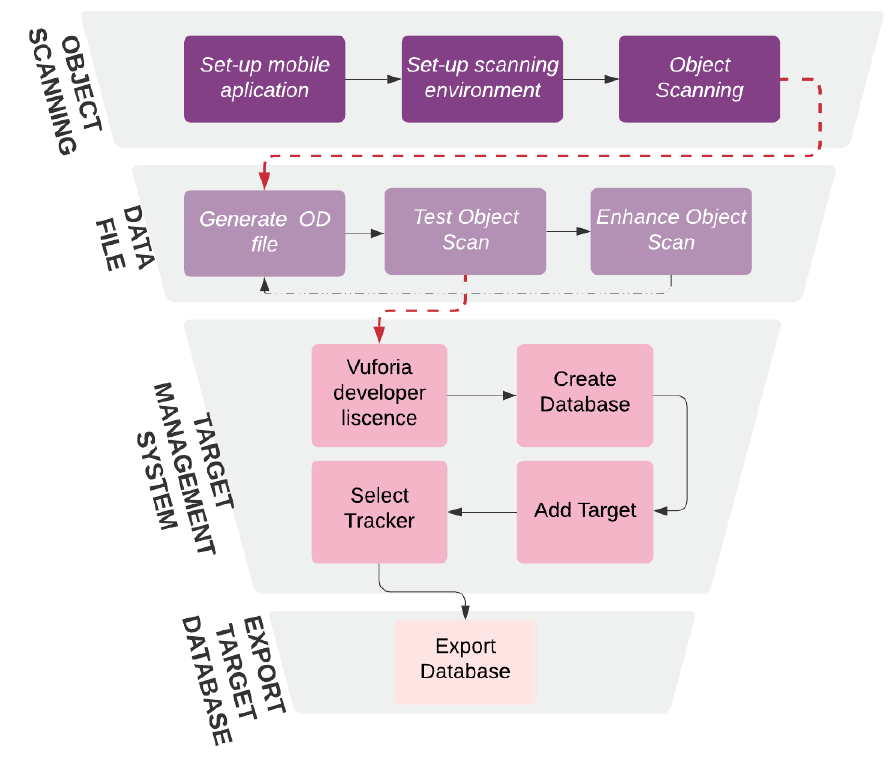
Figure 5. Vuforia object tracking framework.